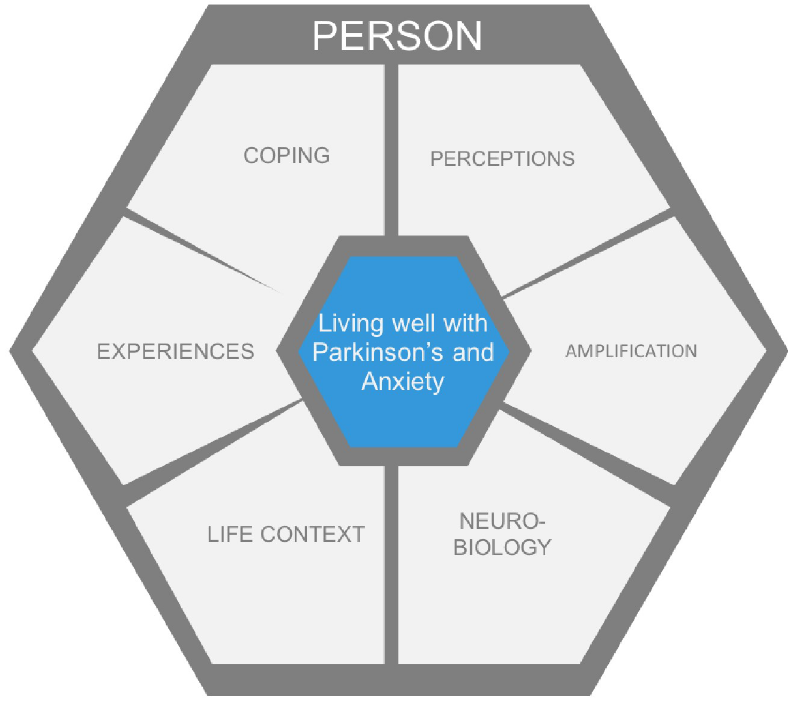
Fig 1. Proposed model of the experience of PWP experience of